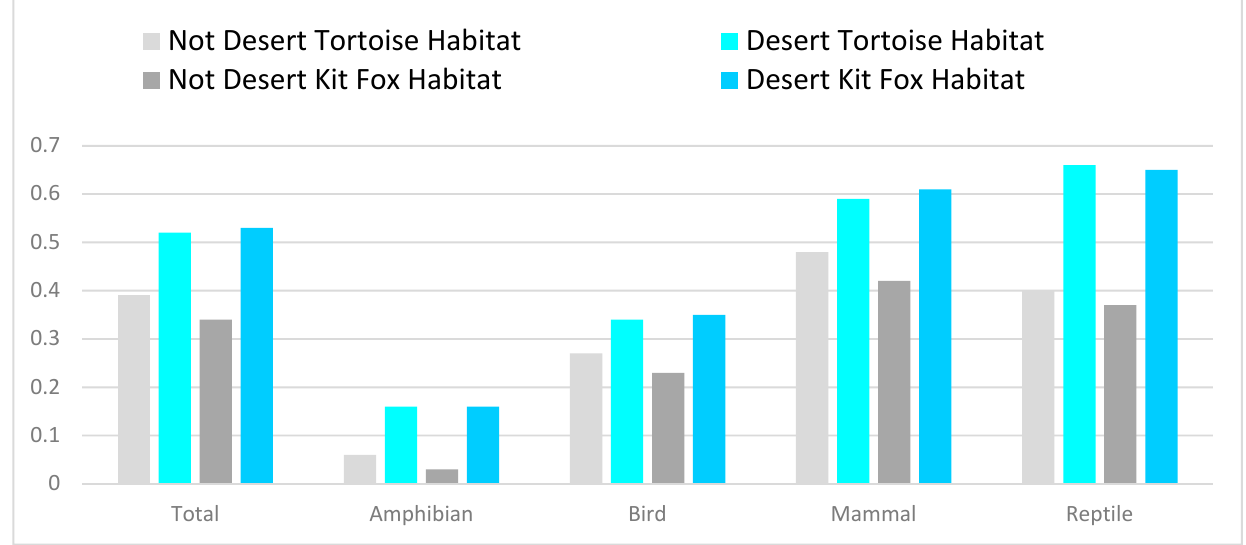
Figure 5. Normalized Index of Biodiversity by taxa (total vertebrate, amphibian, bird, mammal, and reptiles) for the Mojave Desert Ecoregion for areas with and without desert tortoise habitat or desert kit fox habitat.